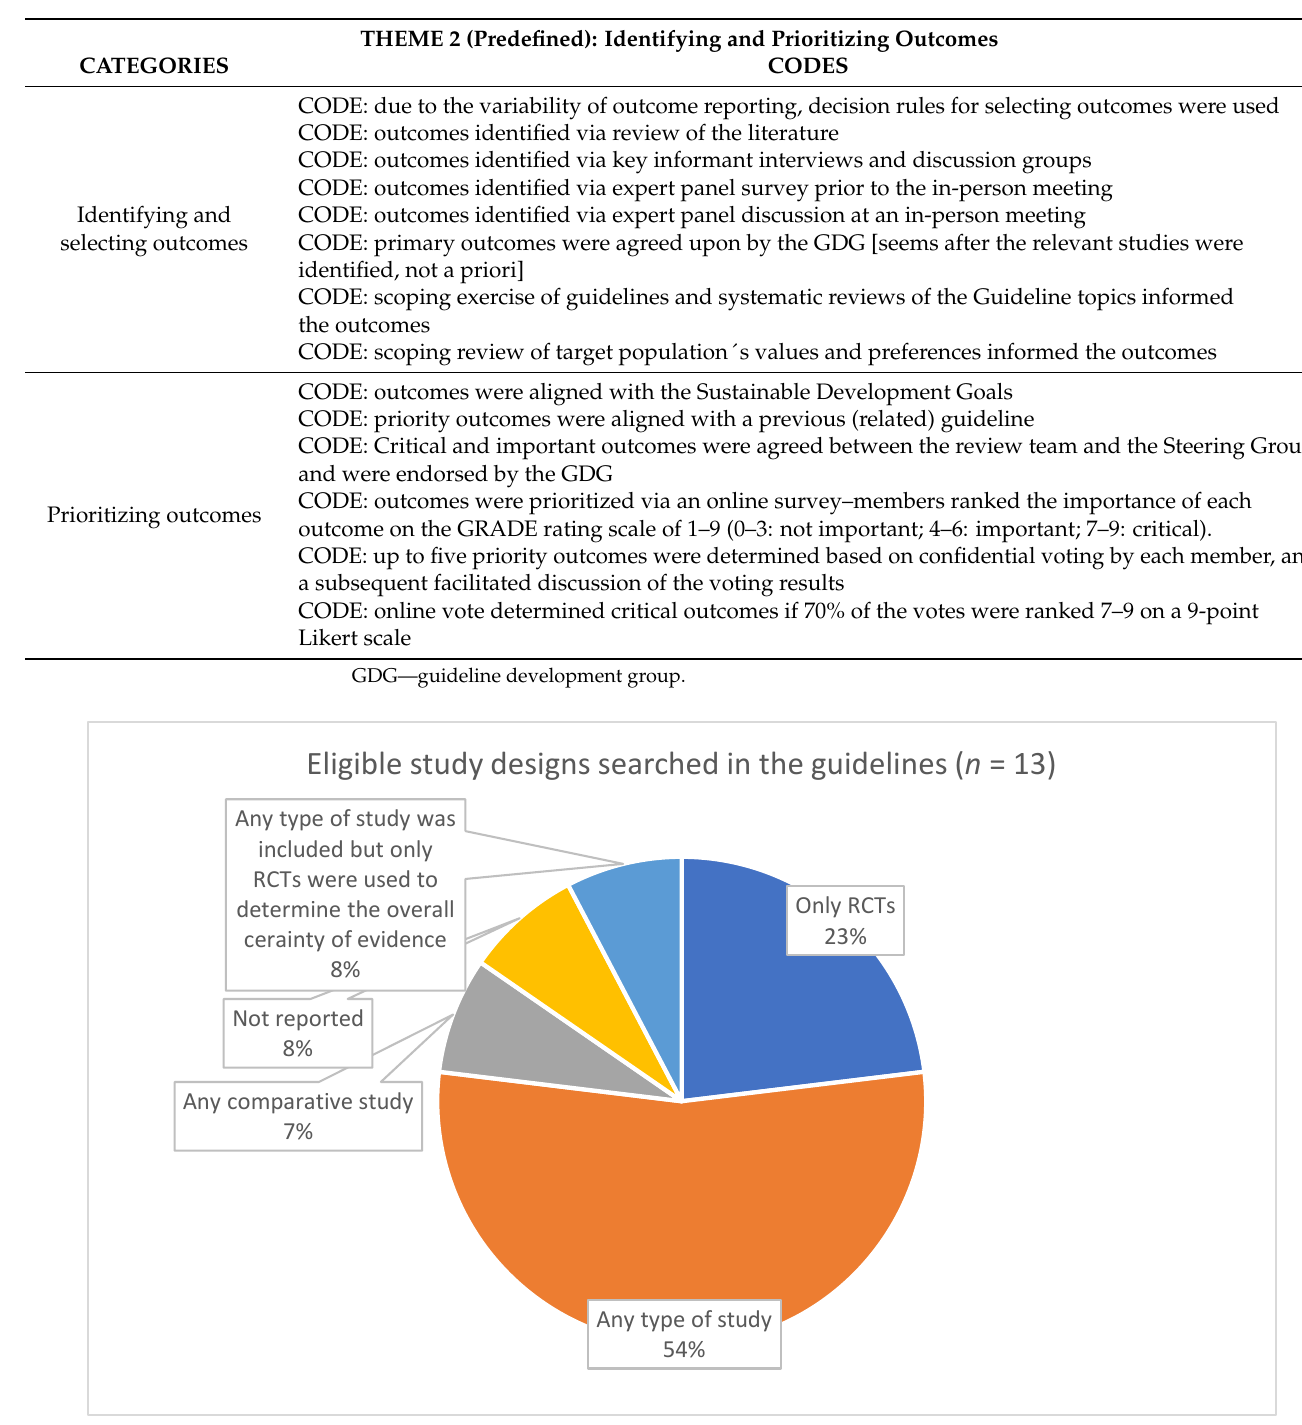
Figure 3. Study designs used to inform the guidelines.